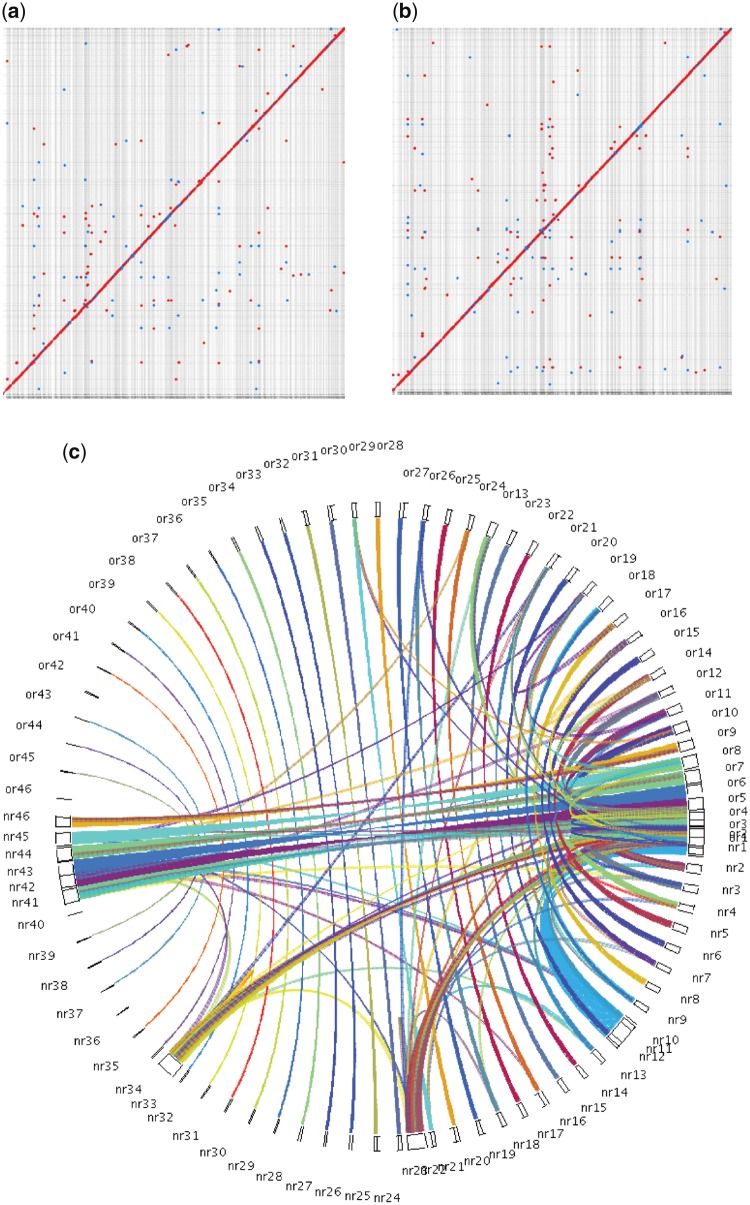
Genome synteny between R. mucilaginosa JGTA-S1 and R. mucilaginosa C2.5t1. (a) Dot plot showing nucleotide vs nucleotide alignment of JGTA-S1 genome assembly (Y-axis) compared with C2.5t1 genome assembly (X-axis) was generated by the NUCmer programme from the MUMmer 3.23 package.20 (b) Dot plot showing alignment after six-frame translations of JGTA-S1 genome assembly (Y-axis) and C2.5t1 genome assembly (X-axis) was generated by the PROmer programme from the MUMmer 3.23 package.20 Red dots indicate matches from the same strand and blue dots indicate matches from opposite strands. The straight red line indicates good alignment between the X and Y axis. (c) Collinear blocks between JGTA-S1 (labelled as ‘or’ in the top half of semi-circle) and C2.5t1 (labelled as ‘nr’ in the bottom half of semi-circle) were identified by MCScanX28 from all-against-all BLASTP searches between JGTA-S1 and C2.5t1. The circle plotter script in MCScanX28 was used to generate the plot. Each rectangle depicts a scaffold in the genome and the synteny between scaffolds is depicted as ribbons. Color figures are available at DNARES online.